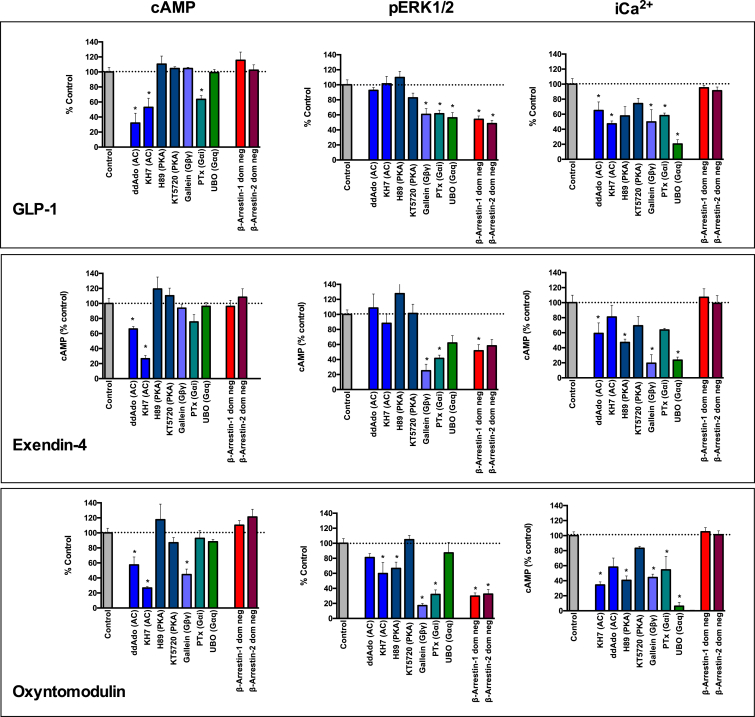
cAMP and Intracellular Calcium Mobilization Are G Protein-Mediated Signaling Pathways, whereas pERK1/2 Is a Composite of G Protein-Mediated and Non-G Protein-Mediated Events, Related to Figures 3, 4, 5, and 6pEC50 concentrations of GLP-1 (top), exendin-4 (middle), and oxyntomodulin (bottom) were assessed for cAMP formation (left), calcium mobilization (right), and pERK1/2 (middle) in the absence (control) and presence of selective inhibitors or dominant-negative constructs. This included effectors downstream of Gαs (adenylate cyclase (AC), ddAdo, KH7) and protein kinase A (PKA), H89, KT5720), selective inhibitors of Gβγ, Gαi or Gαq (Gallein, Petussis toxin (PTx) and UBO respectively) and dominant negative versions of β-Arrestins 1 or 2. Data were normalized to % response in the absence of inhibitor/dominant-negative expression of β-arrestin to assess the importance of the various signaling effectors in peptide-mediated cAMP formation, calcium mobilization, and pERK1/2.